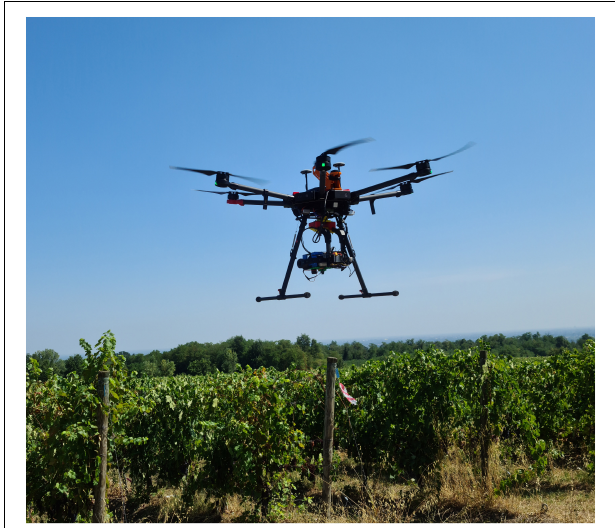
FIGURE 1 | Unmanned Aerial Vehicle used in the study equipped with hyperspectral (HS) imaging